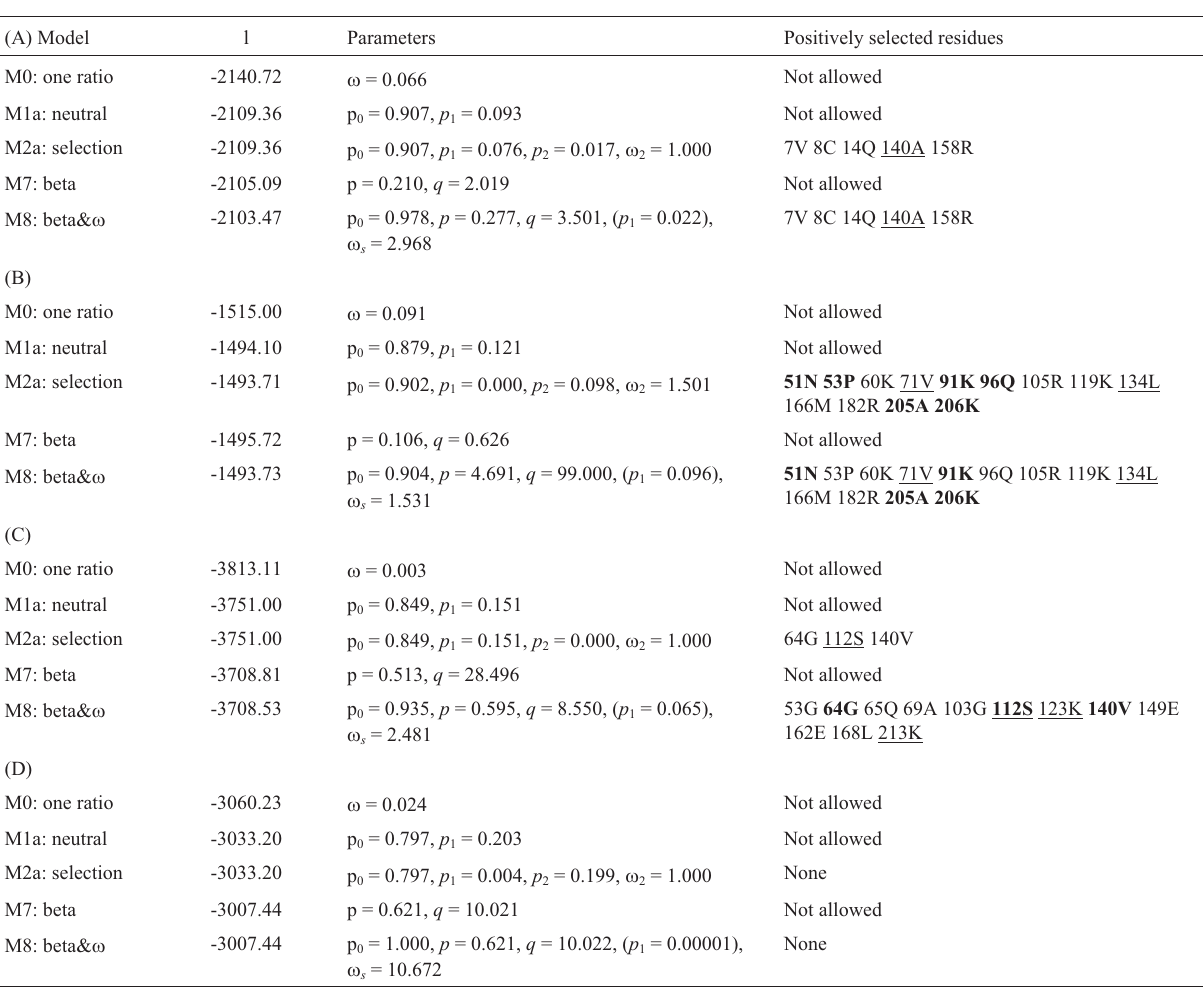
Table2 -PositiveselectiontestsforputativeconvergentMnSODgenesusingsitemodelsofPAML.Theresiduesinboldmeantheposteriorprobabilities are > 0.95 and only the values > 0.5 are presented to indicate the positive selective sites. The residues in underline correspond to the colored ones in the HCA plots and amino acid alignment figures. (A) Animal ( H. sapiens, G. gallus, X. laevis, and D. rerio ) in Figure 2; (B) Enterobacteriaceae ( E. coli, T. ptyseos, and Y. enterocolitica ) in Figure 3; (C) Archaea and relatives ( C. symbiosum, C.N. maritimus, D. acidovorans, C .testosteroni, M. flagellatus, B. marina, and P. maris ) in Figure 4; (D) Cyanobacteria ( A. variabilis, L. boryana, T. erythraeum, and C. watsonii ) in Figure